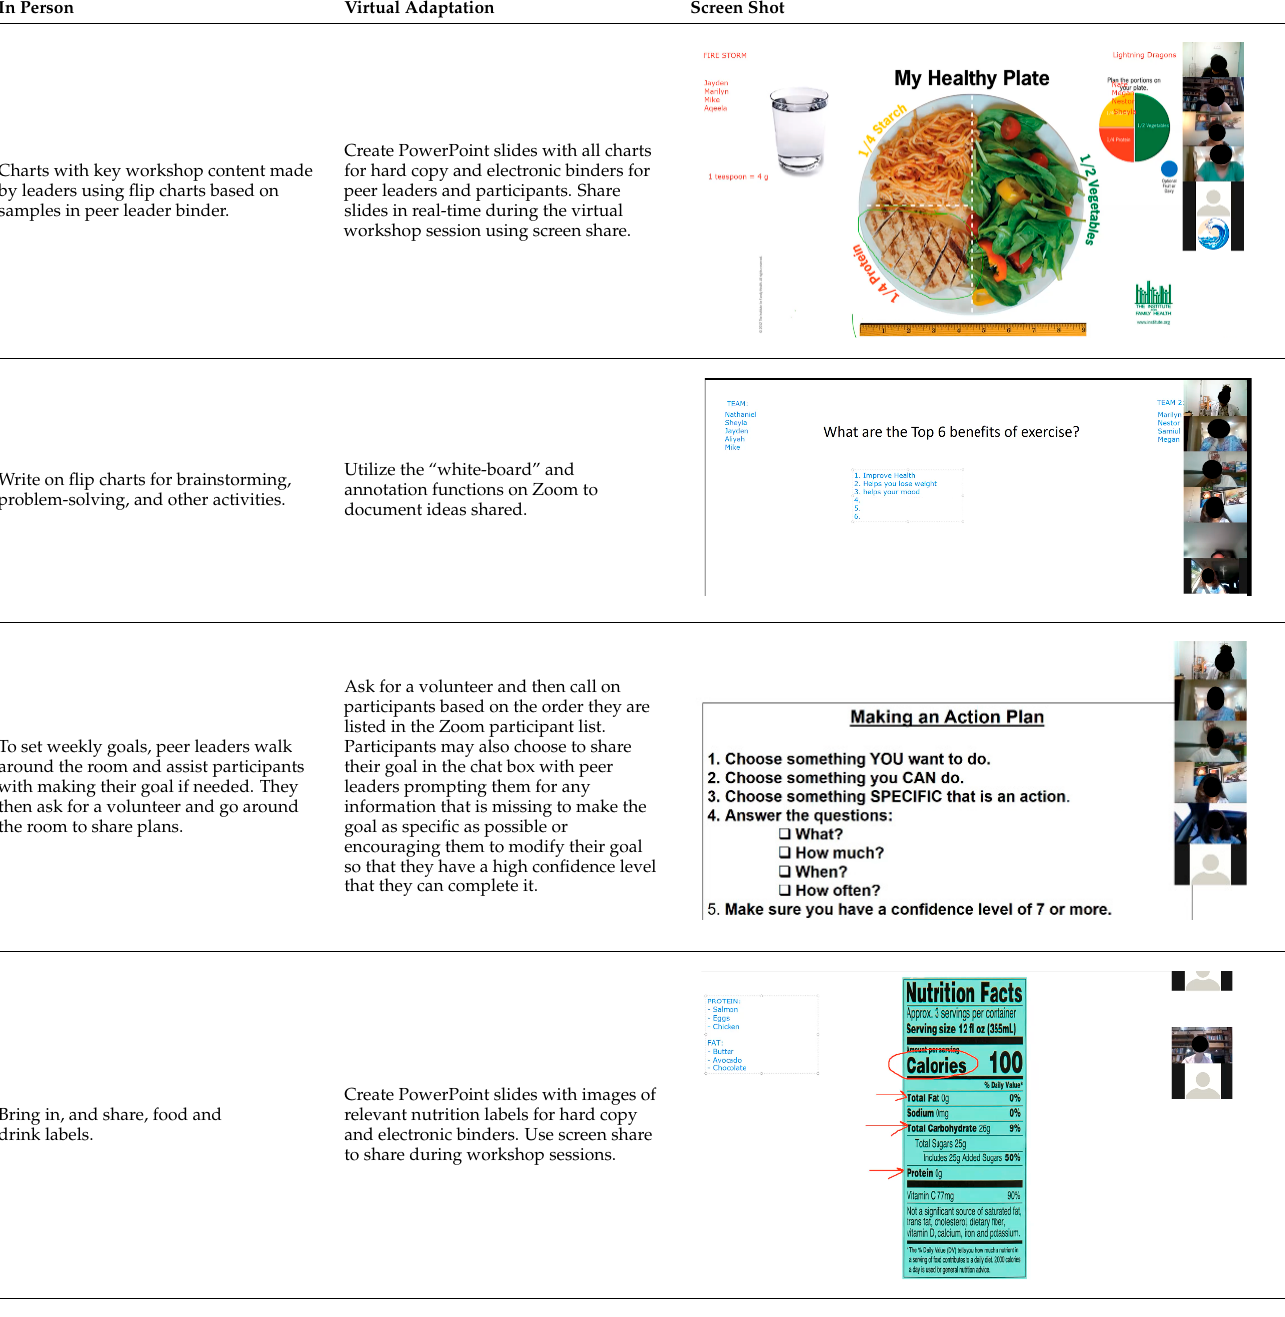
Table 1. Adaptations for virtual program delivery.